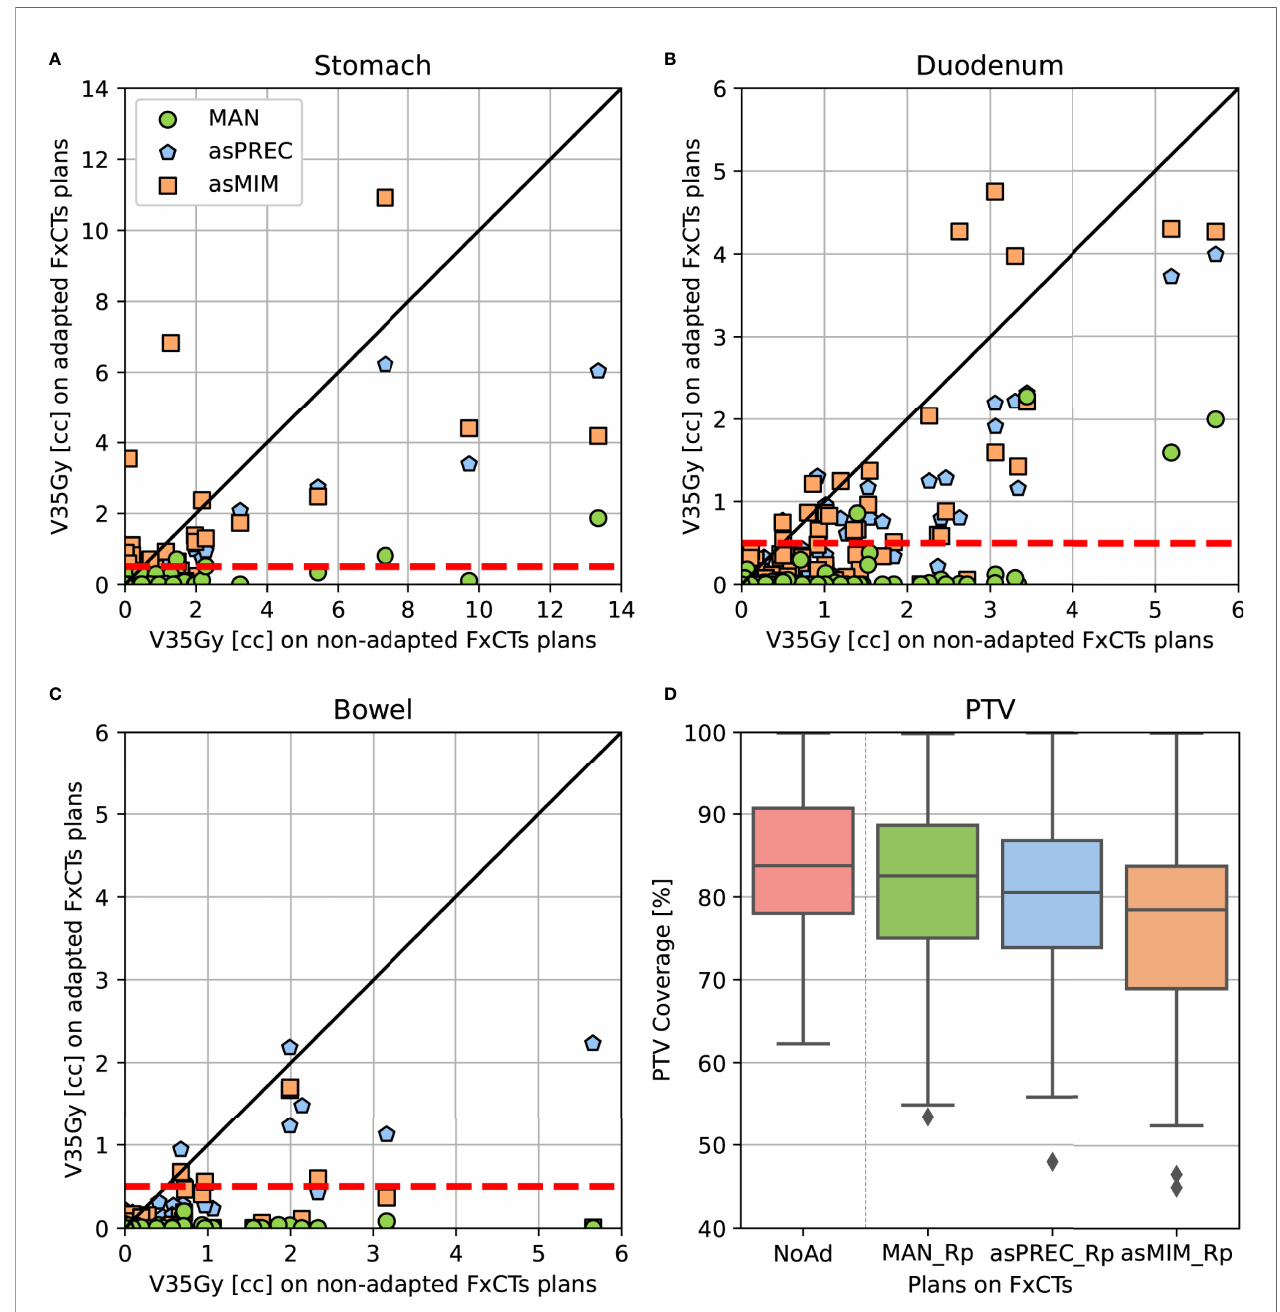
FIGURE 3 | Pair-point comparison of OAR V35Gy parameter on non-adapted vs. adapted plans using manual and autosegmented contours with Precision (asPREC) and MIM (asMIM) on the stomach (A) , duodenum (B) , bowel (C) . Dashed lines depict OAR dose-constraints (V35Gy < 0.5 cc). In (D) , PTV coverage boxplot comparison of non-adapted (NoAd – red) vs. replanned doses: MAN_Rp (green), asPREC_Rp (blue) and asMIM_Rp